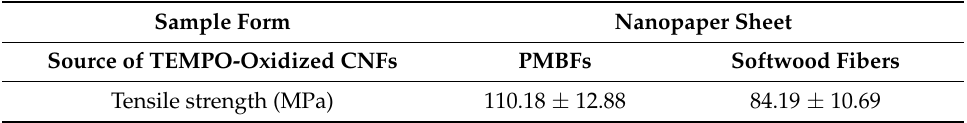
Table 1. Tensile strength of nanopaper sheets formed by TEMPO-oxidized CNFs from PMBFs and softwood